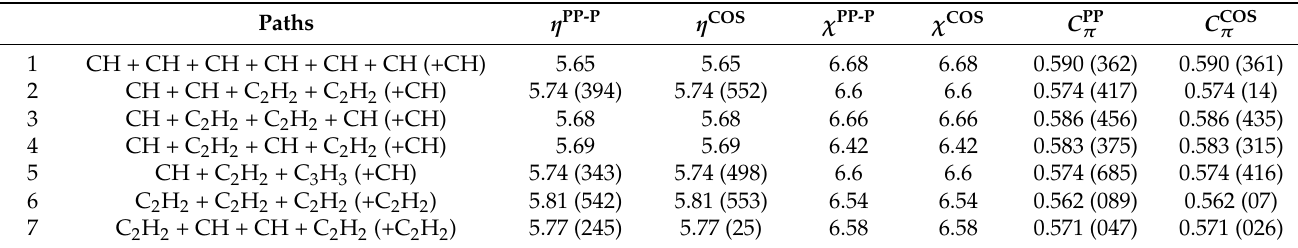
Table 8. The same information as in Tables 6 and 7 for the target C 6 H 6 molecule; the final add-bonding (+ . . . ) indicates the necessary closure step in benzene ring